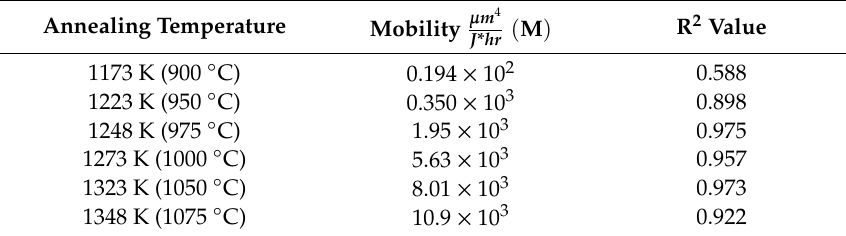
Figure 3. Representative images of samples solution annealed at 1173 K (900 ◦ C) for ( a ) 0.5 h and ( b ) 4 h and annealed at 1348 K (1075 ◦ C) for ( c ) 0.5 h and ( d ) 4 h. Table 1. Mobility (M) values for the lightweight steel at varying annealing temperatures, with least squares fit (R 2 ) shown for reference.